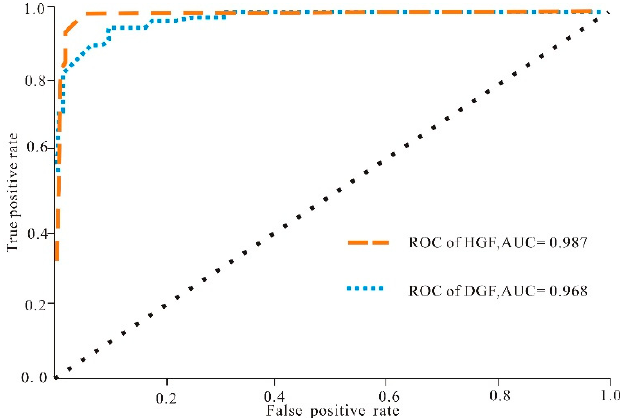
Figure 6. ROC curves for the lithology identification based on the XGB combined with BO in the DGF and HGF; AUC, area under the ROC curve.